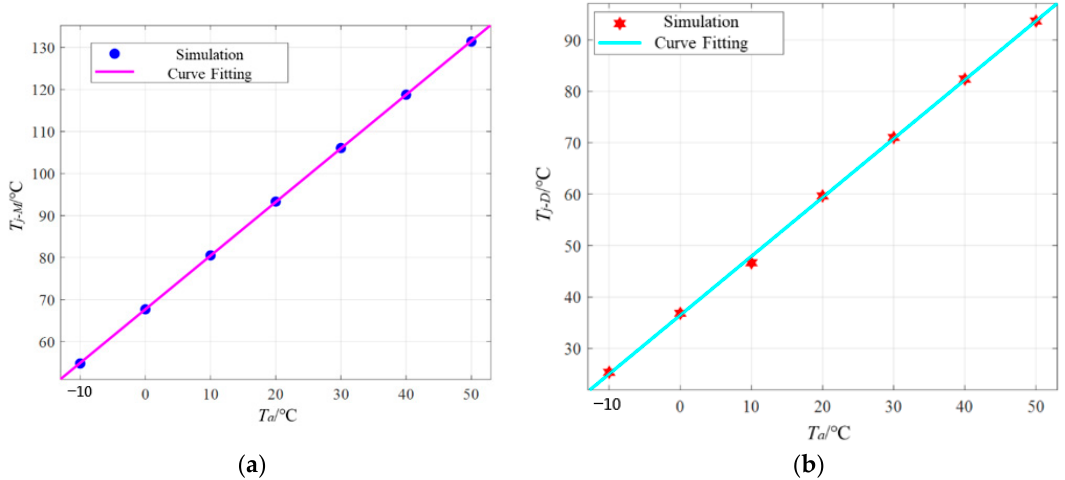
Figure 14. The relationships between junction and ambient temperatures: ( a ) for MOSFET, ( b ) for diode.